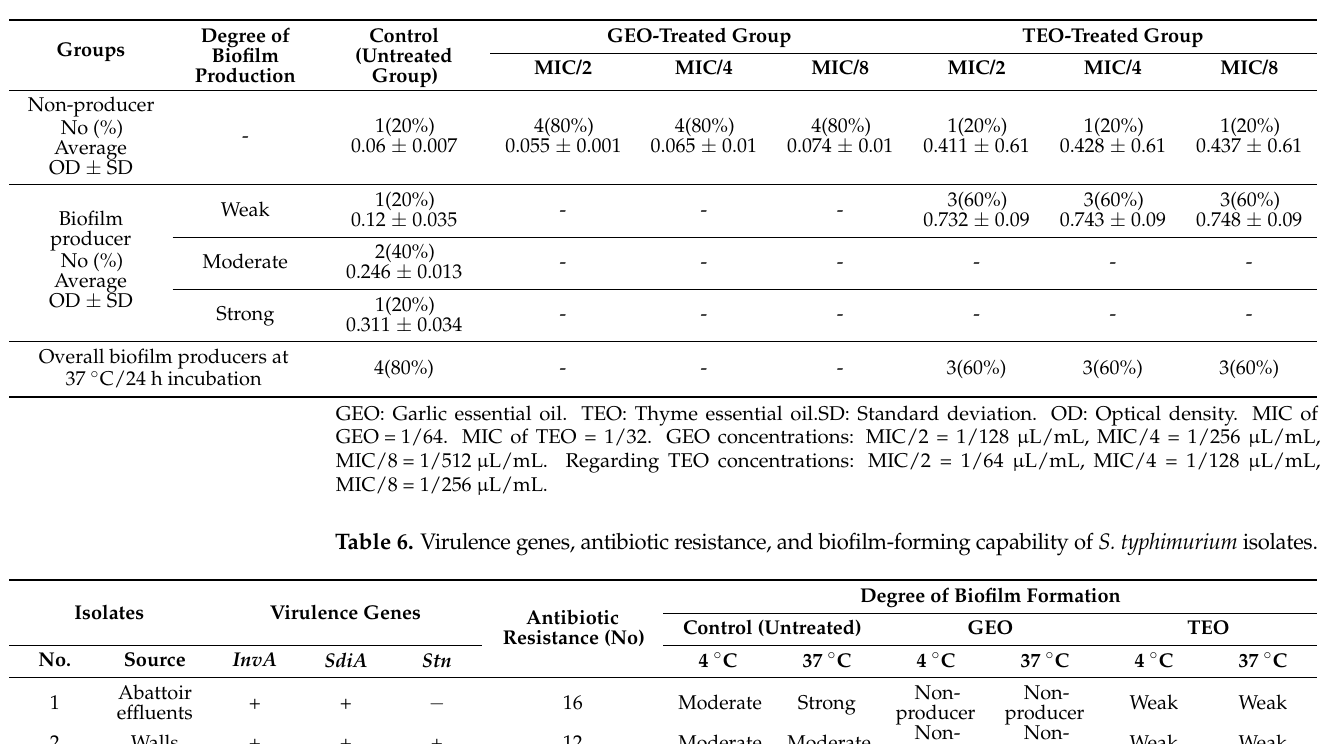
Table 5. Development of biofilm by S. typhimurium in untreated and treated groups at 37 ◦ C.